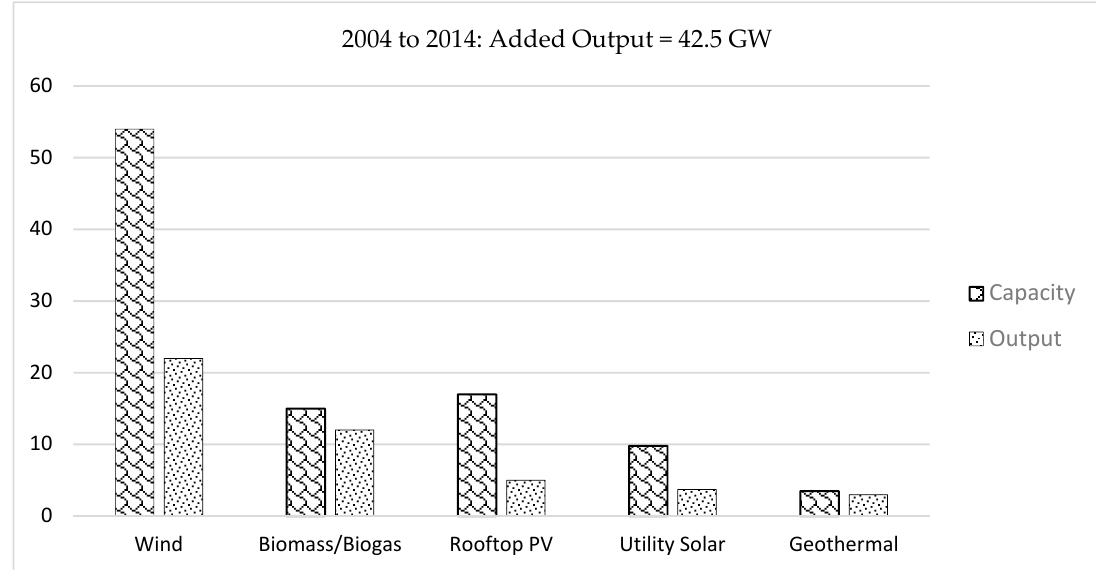
Figure 5. Output vs. installed capacity for various global renewable sources.